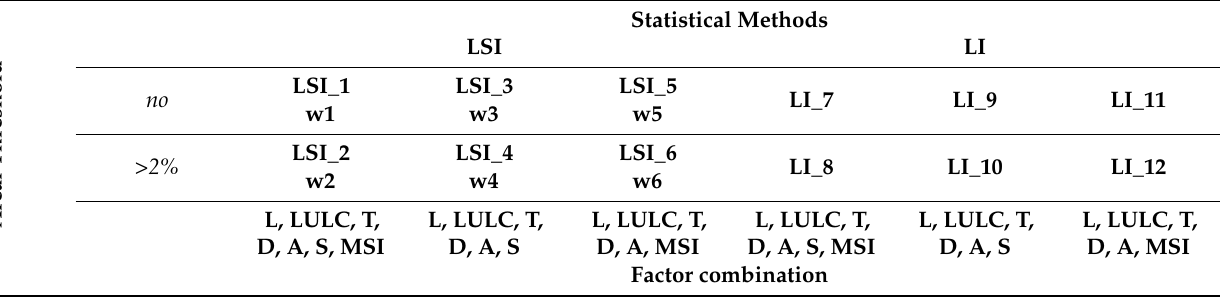
Table 2. Scheme of the experimental design of the